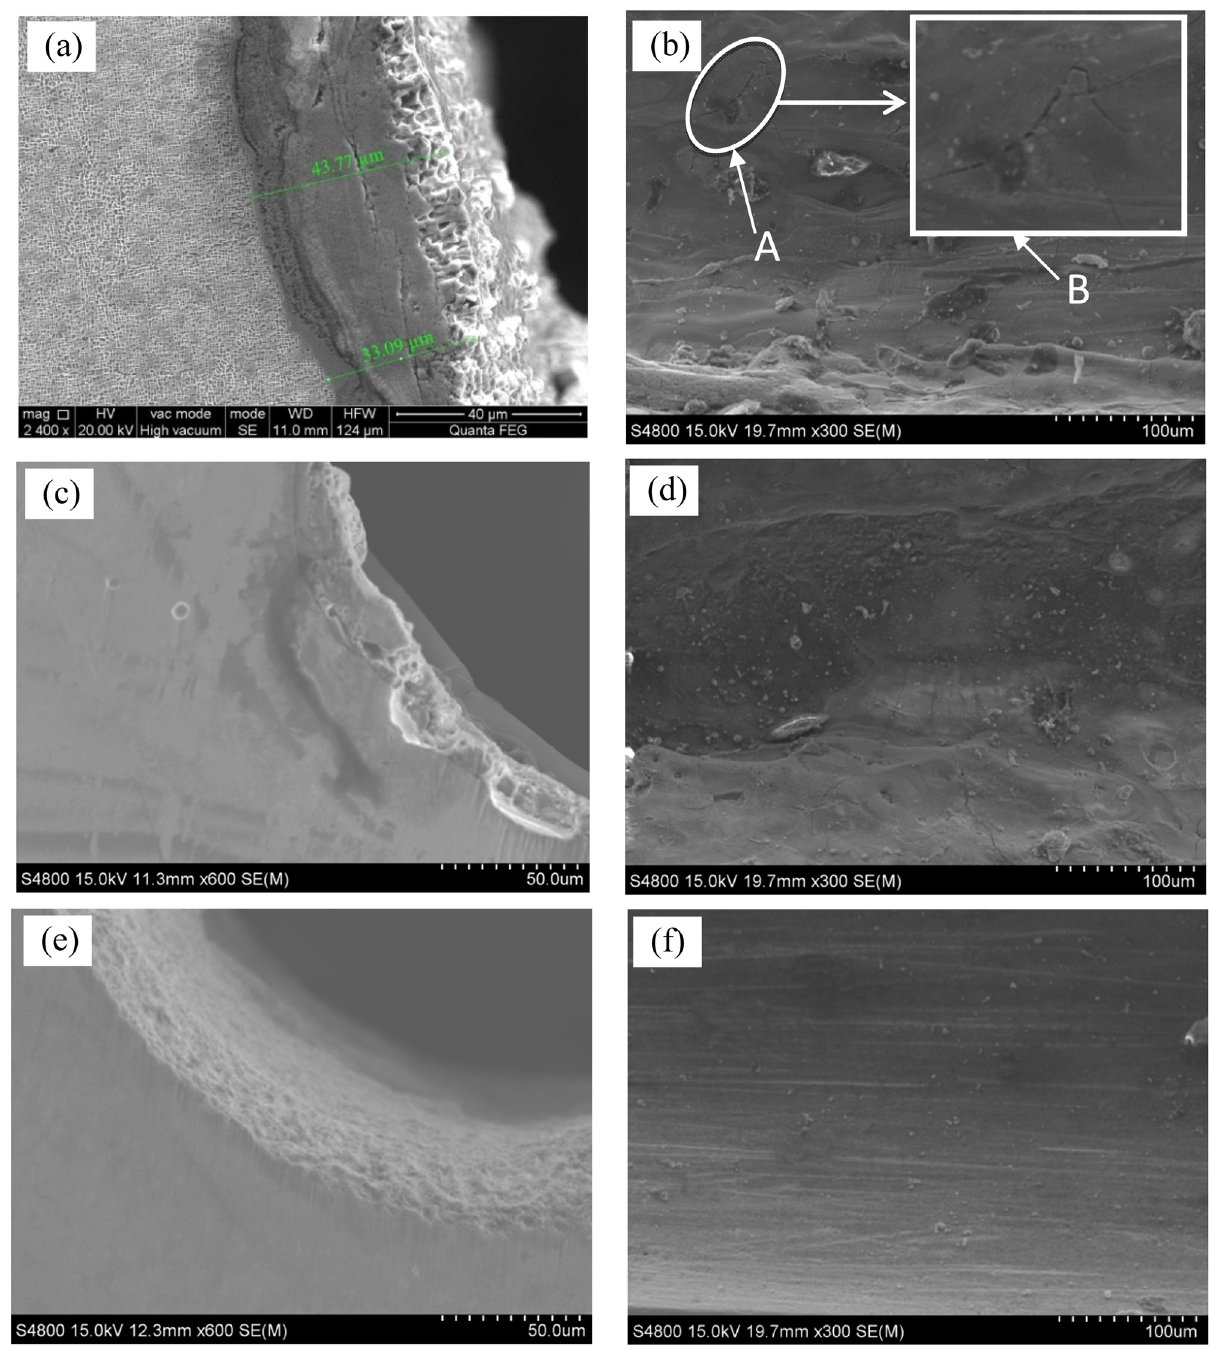
Figure 4: Micrographs of fi lm cooling holes ( a and b ) MSLD, ( c and d ) EDM, and ( e and f )